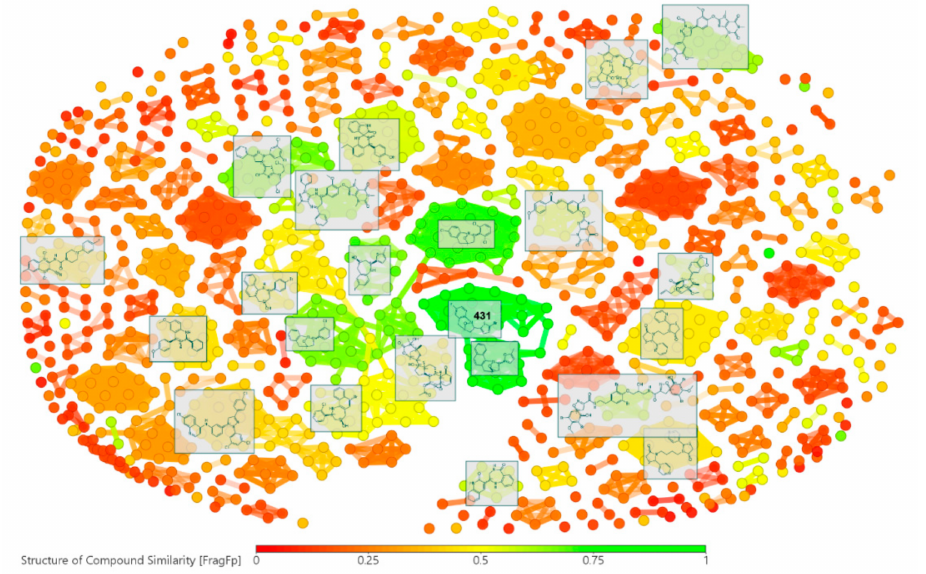
Figure 5. Similarity chart of the custom-made library. This plot was obtained after structure similarity analysis using the substructure fragment dictionary-based binary fingerprint descriptor (FragFp)